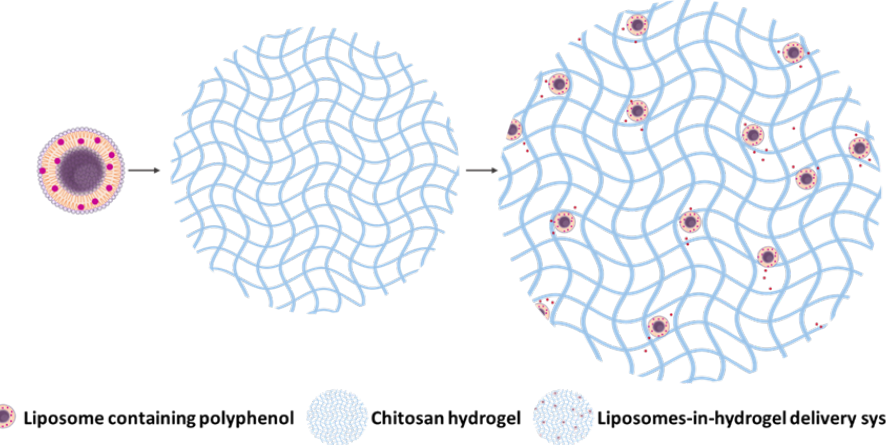
Figure 1. Graphical description of the liposomes-in-hydrogel delivery system for model polyphenol.